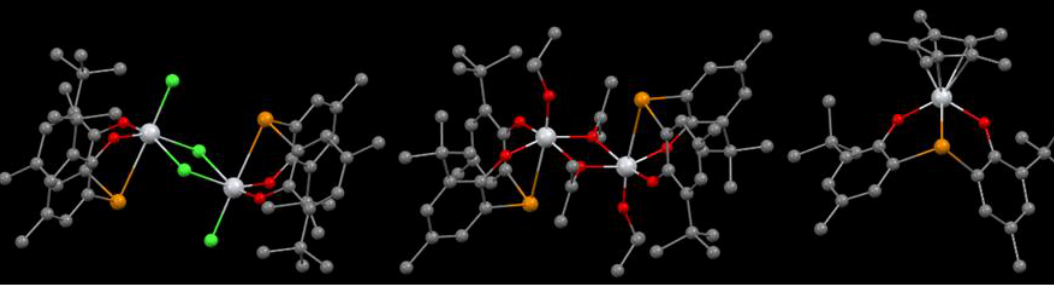
Figure 4. Molecular structures of complexes 6 (left), 8 (center) and 10 (right) [8].